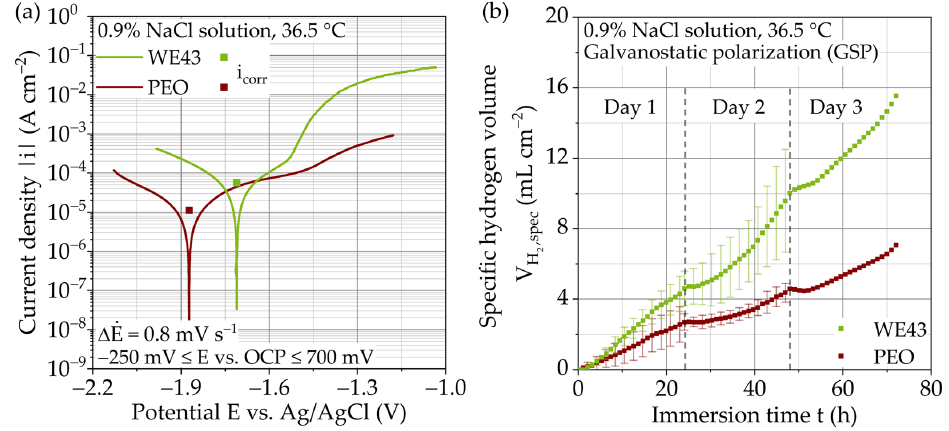
Figure 6. Experimental procedure and number of specimens for each time